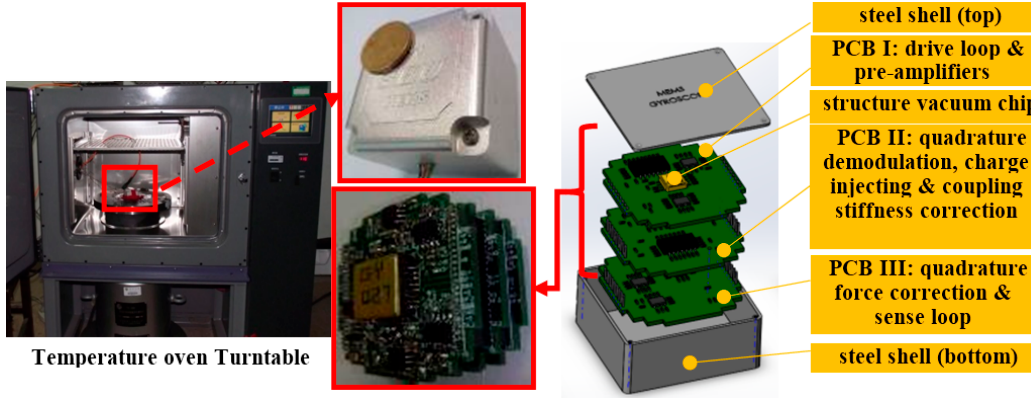
Figure 13. Experimental equipment and gyro section view.